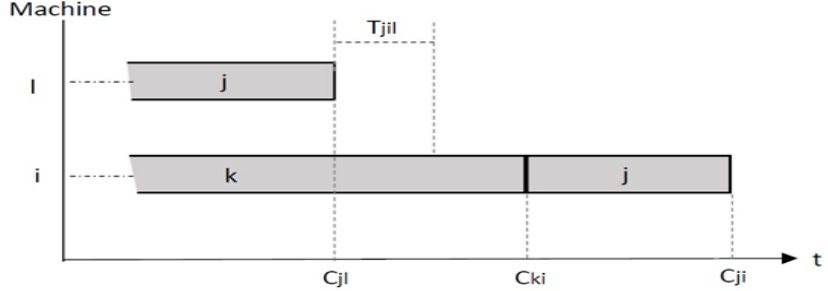
Figure 6. The output of constraint sets 10 is acting, C jl + T jil < C ki Constraints 11 and 12 define the makespan. Constraints 13 and 14 represent the decision variable of completion time of surgical operation 𝑗 in OR 𝑖 , which always has a minimum value of zero. Constraints 15 and 16 are constraints of binary decision variables.